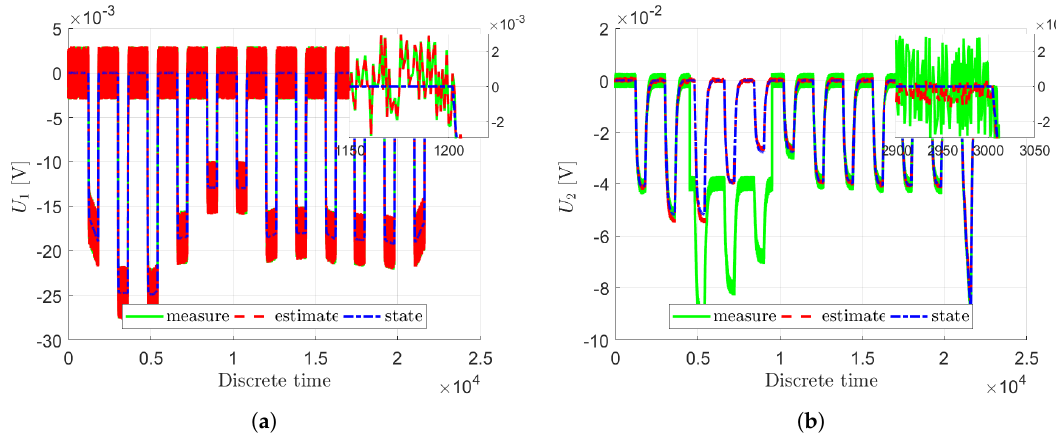
Figure 4. State variables U 1 ( a ) and U 2 ( b